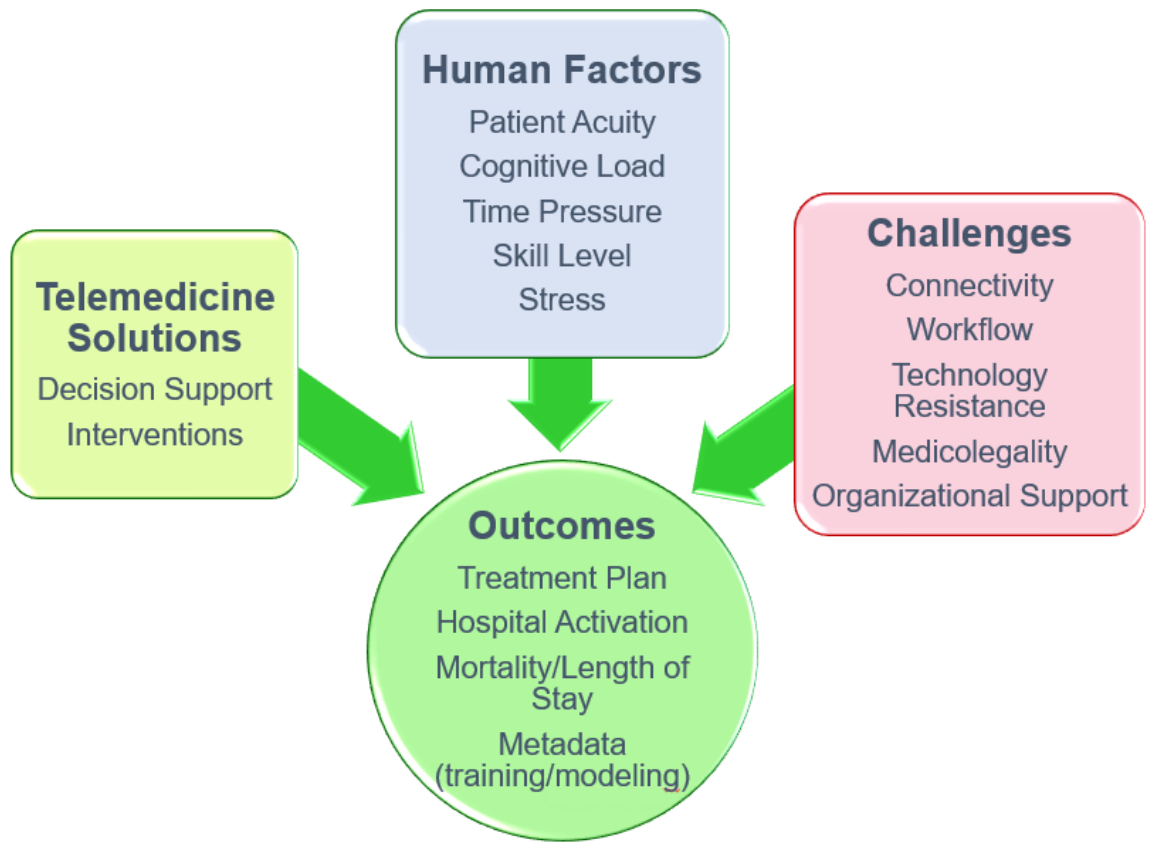
Figure 2. A network of factors influencing outcomes related to hospital operation and patient